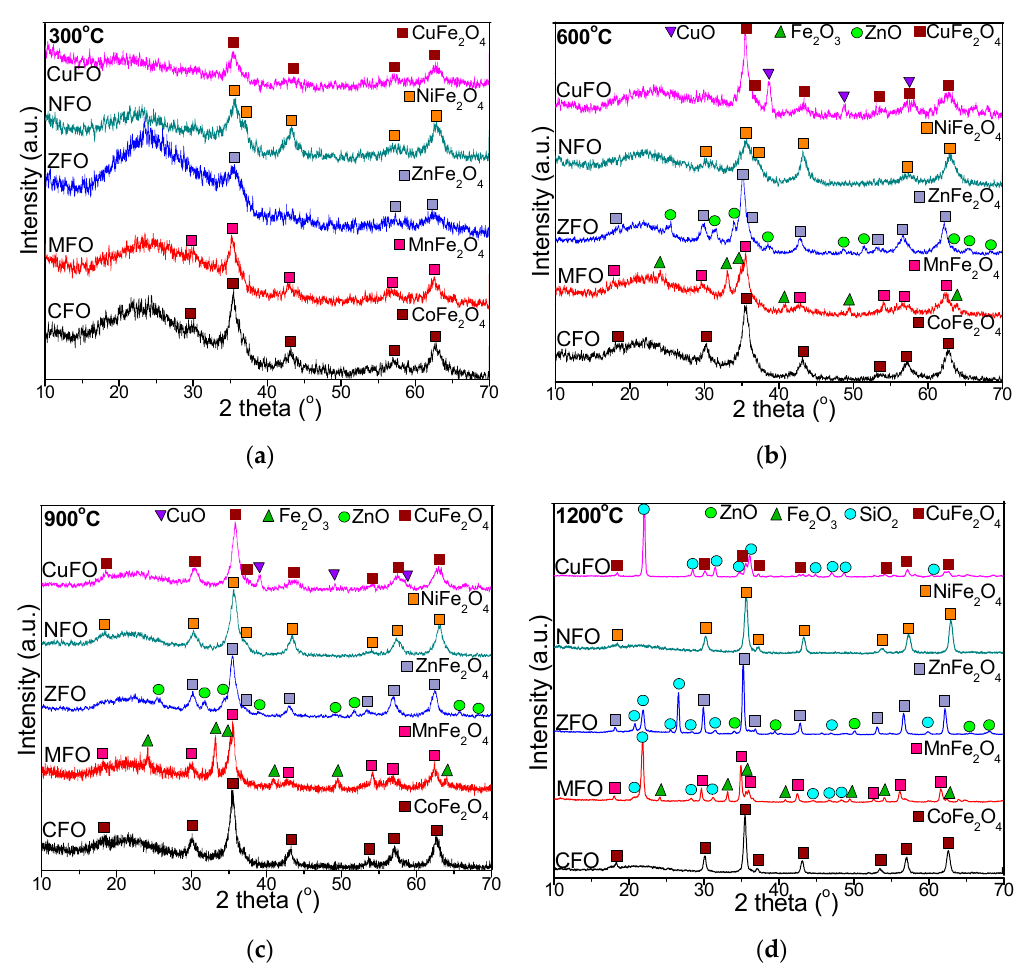
Figure 3. X-ray diffraction (XRD) patterns of CFO, MFO, ZFO, NFO, CuFO NCs annealed at 300 °C ( a ), 600 °C ( b ), 900 °C ( c ), and 1200 °C ( d ).